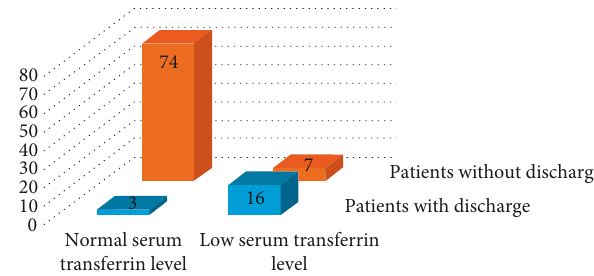
Figure 1: Correlation between the total number of patients and patients having a low serum transferrin level.